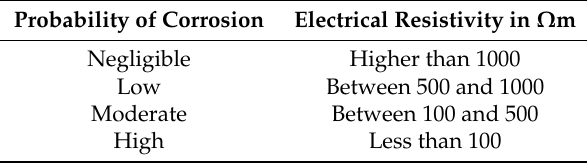
Table 1. Electrical resistivity in relation to corrosion probability based on RILEM TC 154